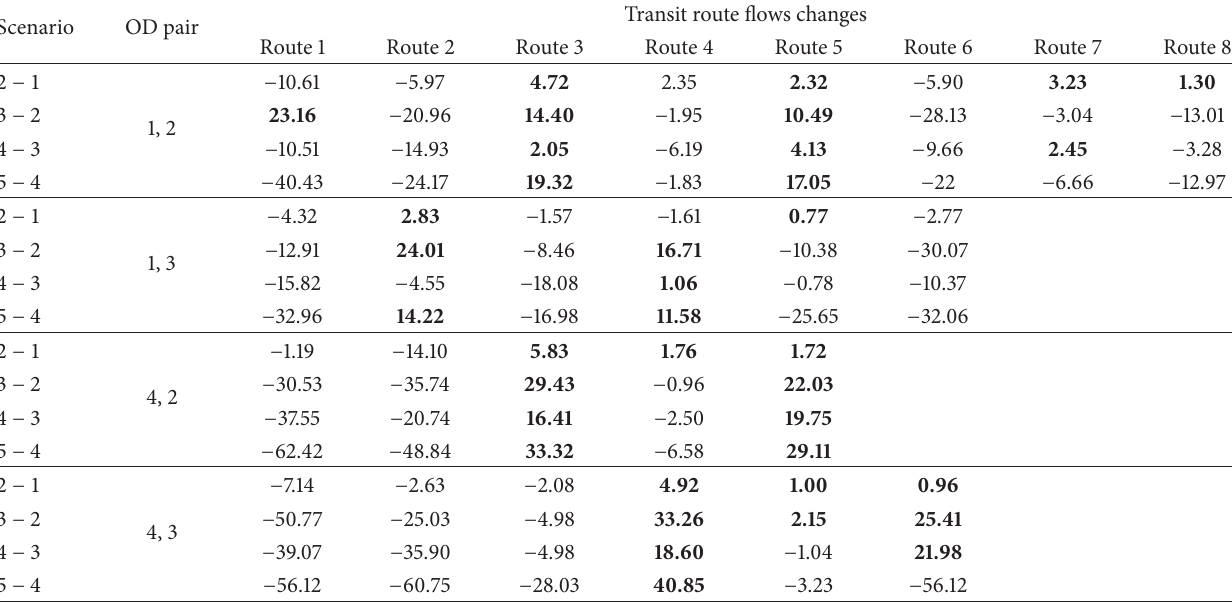
Table 9: The changes of transit route flows considering different scenarios ( 𝛼 = 5 ).